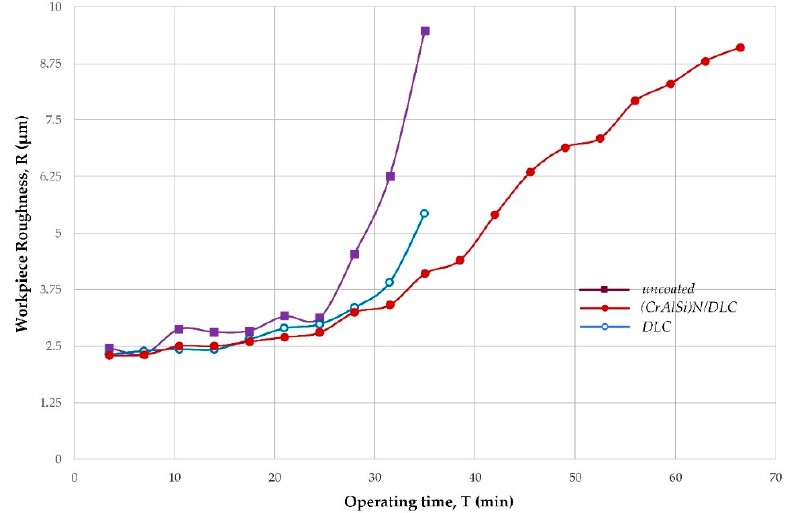
Figure 15. Dependence of the roughness of the treated workpiece surface of structural steel 41Cr4 on the operating time of end mills with different coatings.